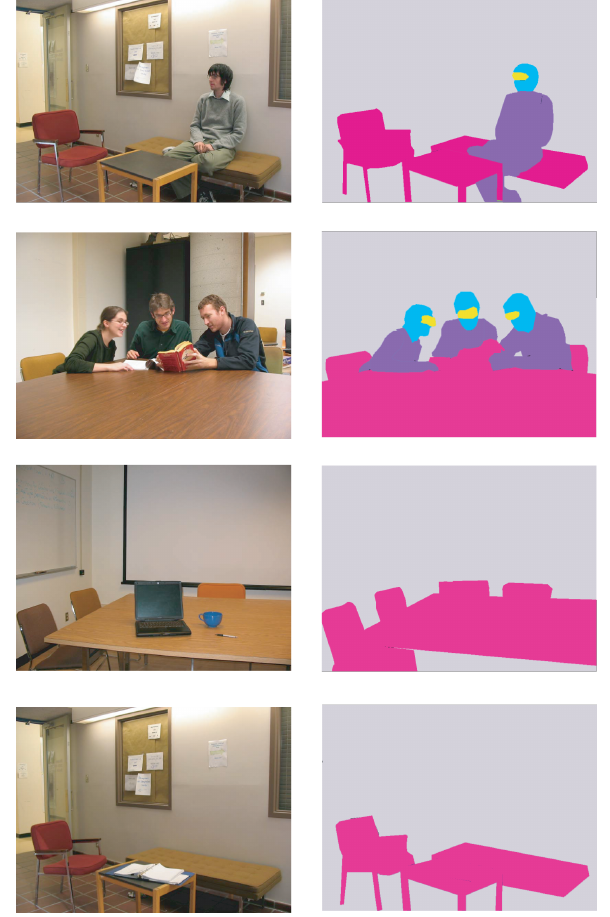
Figure 1. Examples of People scenes and No People scenes used in the experiment. (left-hand column); Corresponding regions of interest used in analysis (eyes, head, body, foreground objects, background objects) (rightward